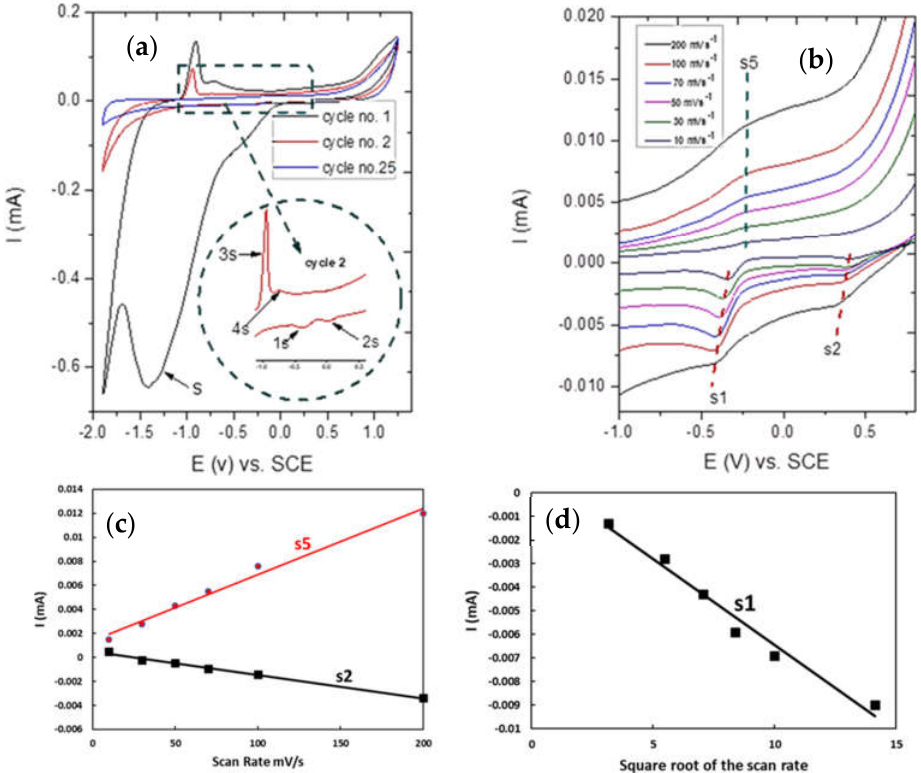
Figure 7. ( a ) Cyclic voltammograms of Sn-OC electrode in 0.1 M KOH at scan rates of 200 mV/s, ( b ) cyclic voltammograms of Sn-OC electrode in 0.1 M KOH at scan rates of 200, 100, 70, 50, 30 and 10 mV/s, ( c ) anodic and cathodic peak currents for Sn-OC electrode in 0.1 M KOH, as a function of the scan rate, and ( d ) as a square root of the scan rate.